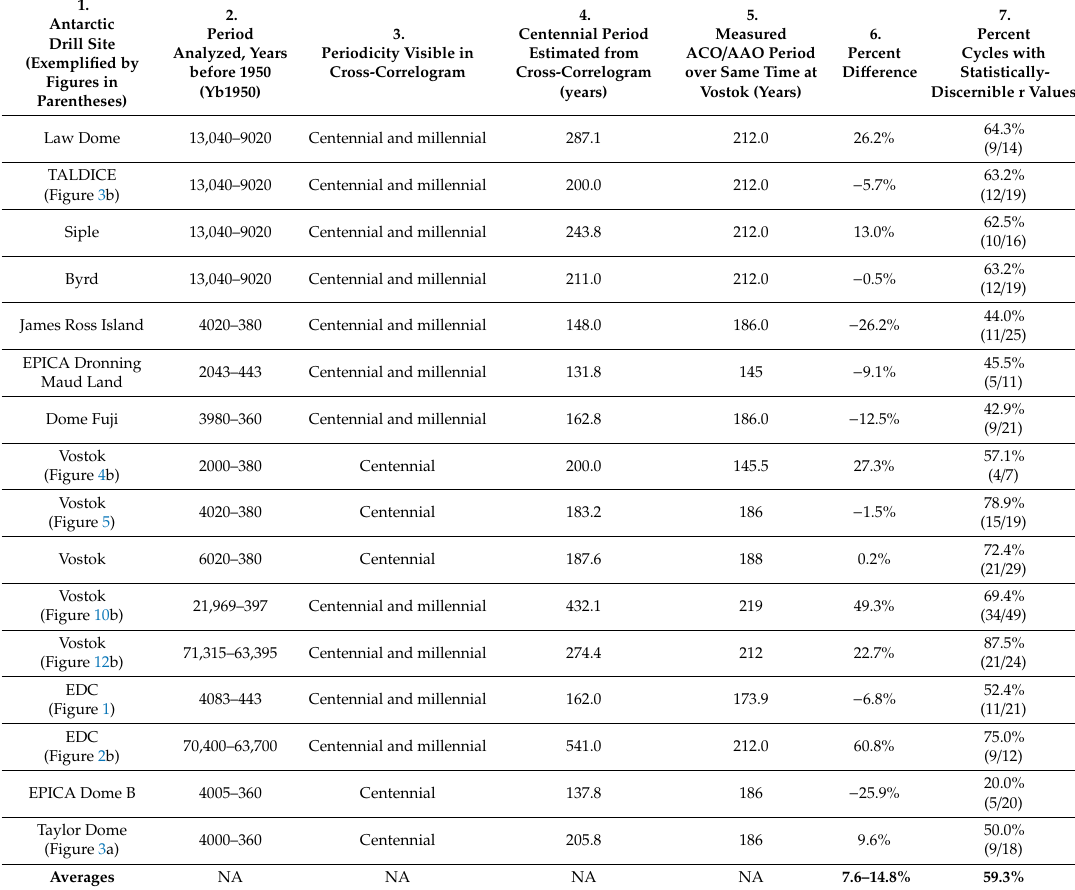
Table 1. Coupling between wind proxies at EDC and local temperature proxies at eleven Antarctic drill sites as measured using lagged